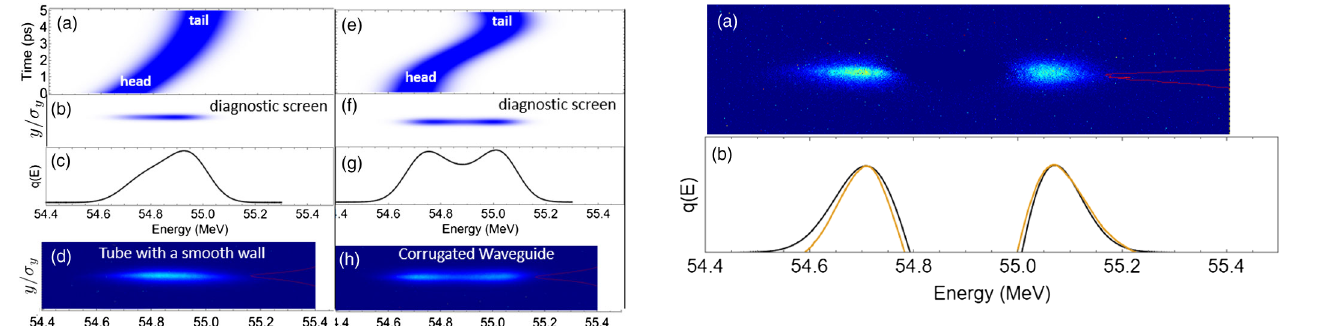
FIG. 16. (a) The difference between two diagnostics screen images, one taken when the electron bunch propagated the CWG with L ¼ 74 mm and one taken when the electron bunch propagated the tube with the smooth wall. (b) The measured energy distribution of the electrons shown in the above plot (orange curve) and the calculated analogous energy distribution (black curve). on the y